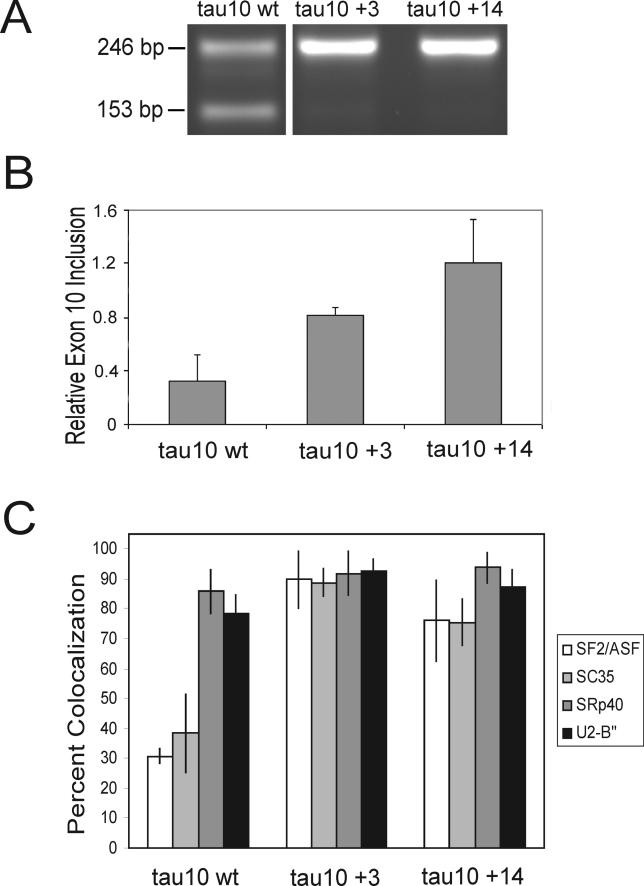
Mutation-Independent Differential Recruitment of Endogenous Pre-RNA Splicing Factors(A) Stable cell lines expressing minigenes containing a G>A mutation at +3 (tau10+3) or a C>U mutation at +14 (tau10+14). Both mutations give preferential inclusion of exon 10 as previously reported for transient expression.(B) Quantitative real-time PCR analysis demonstrating the preferential inclusion of exon 10 in tau10+3 and tau10+14 compared to tau10wt. Values represent averages ± standard deviations from at least three experiments. Values of included exon 10 are normalized to total minigene RNA.(C) Quantitative analysis of recruitment of endogenous splicing factors to tau10+3 or tau10+14. Recruitment of splicing factors to tau transcription sites detected by combined RNA-FISH using specific probes against the tau minigene and IF microscopy with specific anti-splicing factor antibodies. Percentage of cells with colocalization of tau RNA-FISH and splicing factor signals is indicated. Values represent averages from at least 100 transcription sites from three experiments ± SEM.